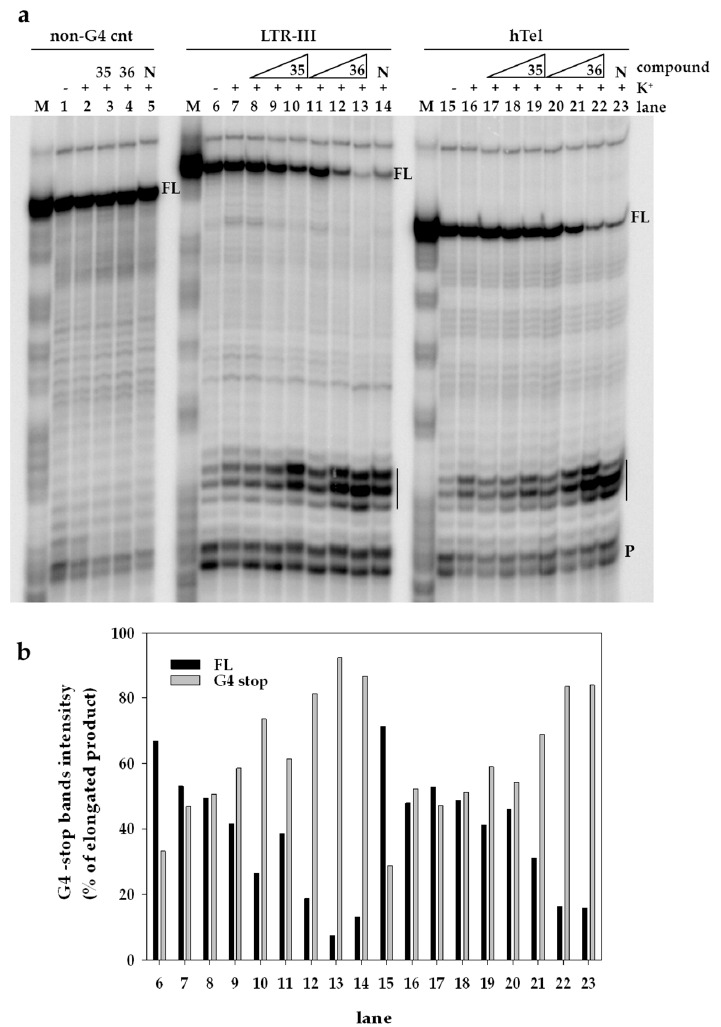
Figure 4. Image of a typical Taq polymerase stop assay. ( a ) LTR-III and hTel templates were amplified by Taq polymerase in the absence (lanes 6 and 15) and presence of 100 mM K + , alone (lanes 7 and 16) or with increasing amounts (50, 100 and 200 nM) of 35 (lanes 8–10 and 17–19) or 36 (lanes 11–13 and 20–22). NDI (N) 200 nM (lanes 14 and 23) was used as control for a non-selective G4-ligand. A template (non-G4 cnt) made of a scrambled sequence unable to fold into G4 was also used as internal control in the absence (lane 1) and presence of 100 mM K + , alone (lane 2) or with 200